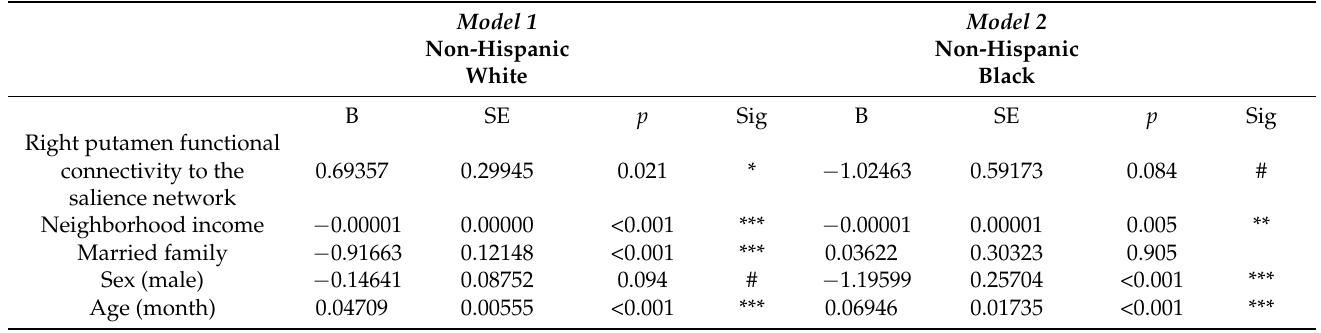
Table 3. Parameter estimates for the effects of right putamen functional connectivity to the salience network on children’s body mass index